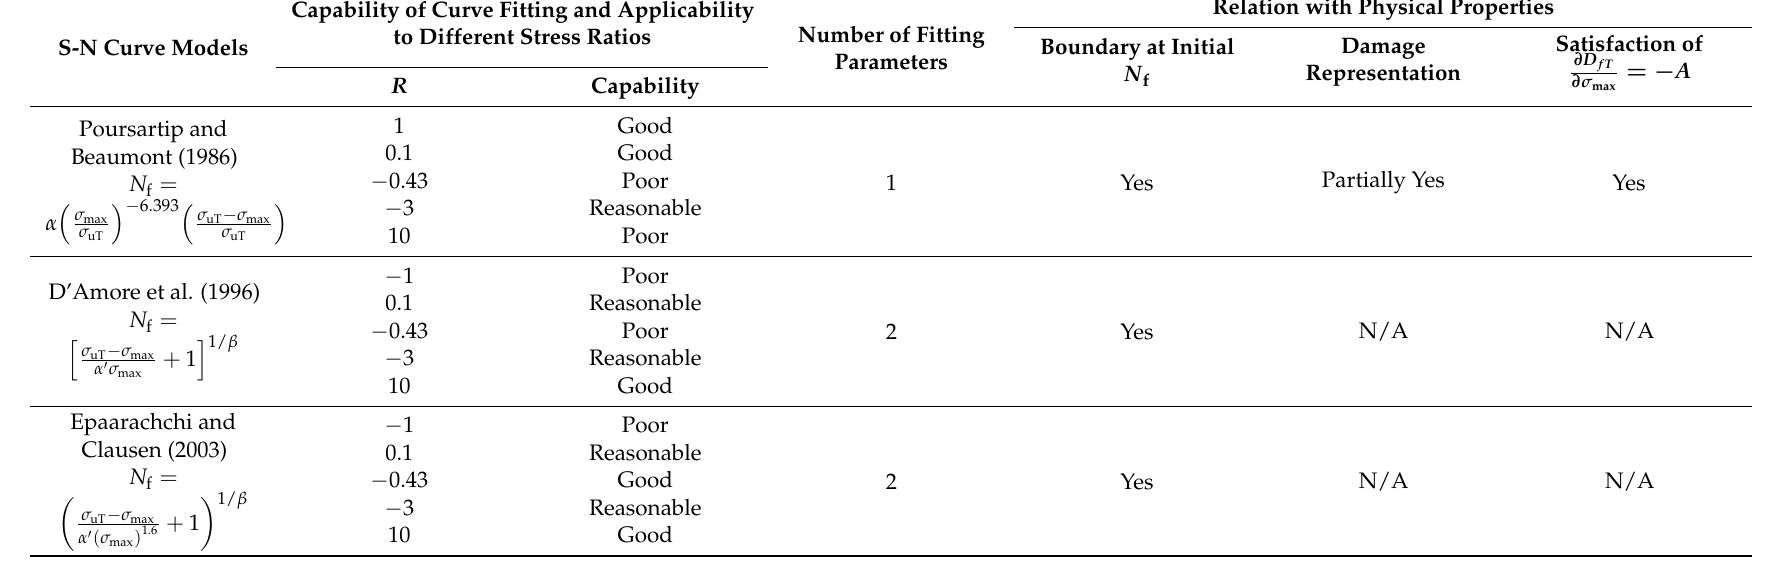
Table 4. S-N curve models developed for stress ratio